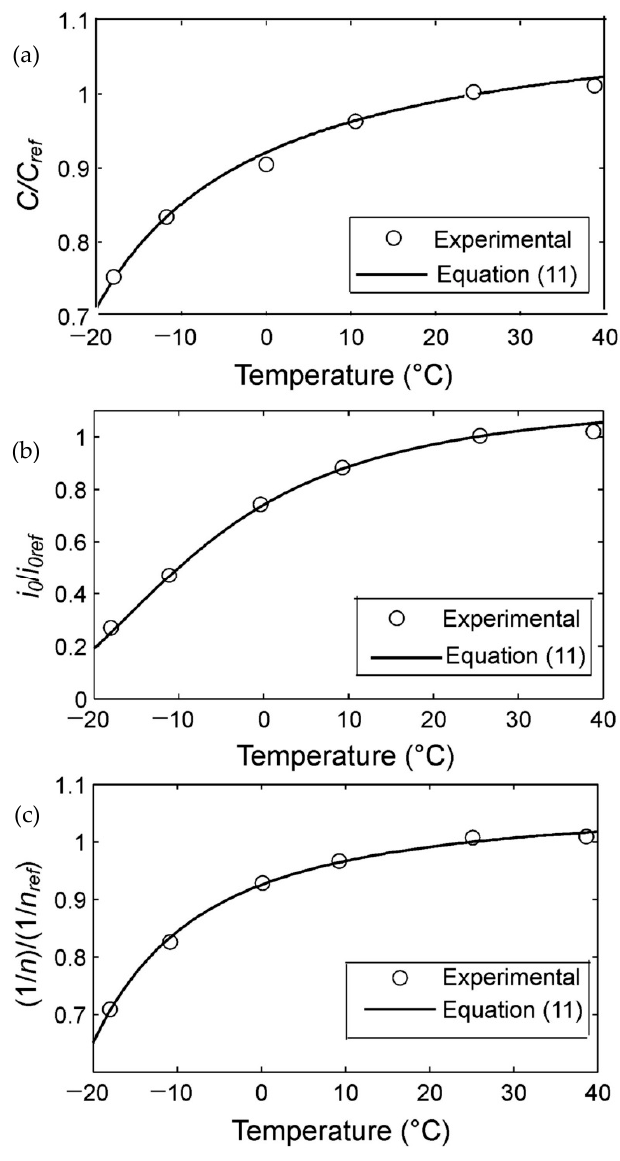
Figure 2. Dependence of parameters C m , i 0 , and 1/n from Equation (6) on temperature. C mref , i 0 ref , and 1/n ref are the parameter values at the temperature T ref : ( a ) parameter C m ; ( b ) parameter i 0 ; ( c ) parameter 1/n .